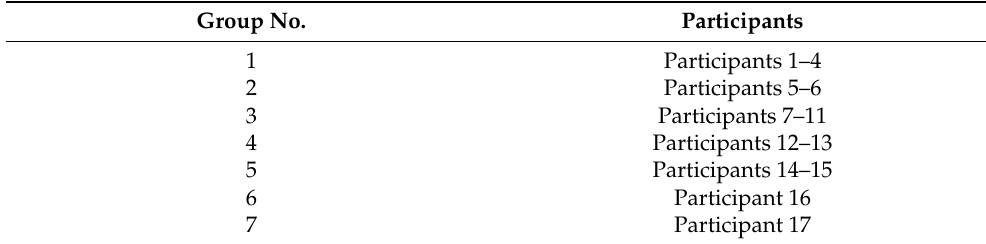
Table 1. List of participants in each group interview. Group